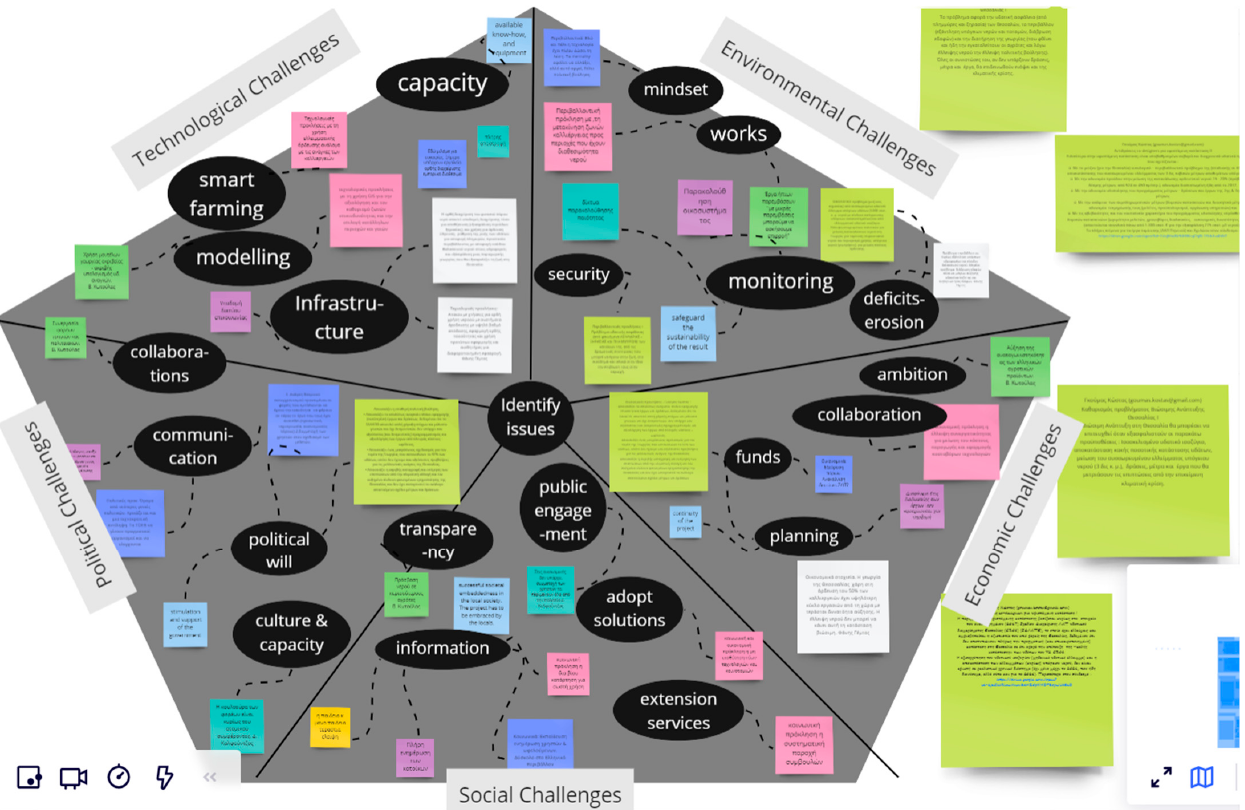
Figure 2. The Pentagonal problem as framed in MIRO, indicatively showing how the Environmental, Technological, Economic, Political and Social issues were simultaneously described by inserting notes, descriptions and connection links in the respective section of the pentagon during the discussions (Adapted from [31]). Here the first level of notes, keywords in black colour, are mainly presented per category of challenges, indicative of the challenges perceived by the stakeholders, expressed by just one word. The other comments are further arguments (in Greek) to support the (English-translated) main keywords provided and to emphasize their importance.